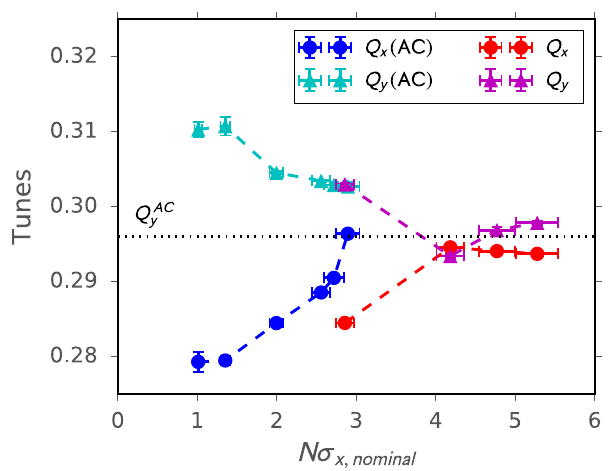
FIG. 17. Measured natural horizontal and vertical tunes vs horizontal excitation amplitudes with Landau octupoles powered at 40 A for ac dipole excitations and free kicks